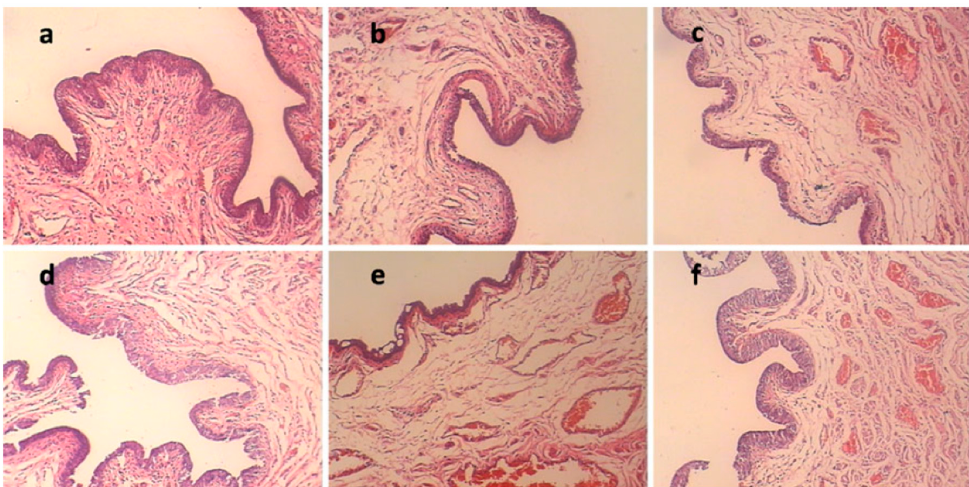
Figure 12. Pathological photos of rabbits’ cervicovaginal tissues after intravaginal application of 0.9% NaCl ( a , d ), hydroxyethyl cellulose (HEC) gel ( b , e ) and methylcellulose (MCS) hydrogel ( c , f ) for 1 day ( a – c ) and 7 consecutive days ( d – f ), respectively [23].